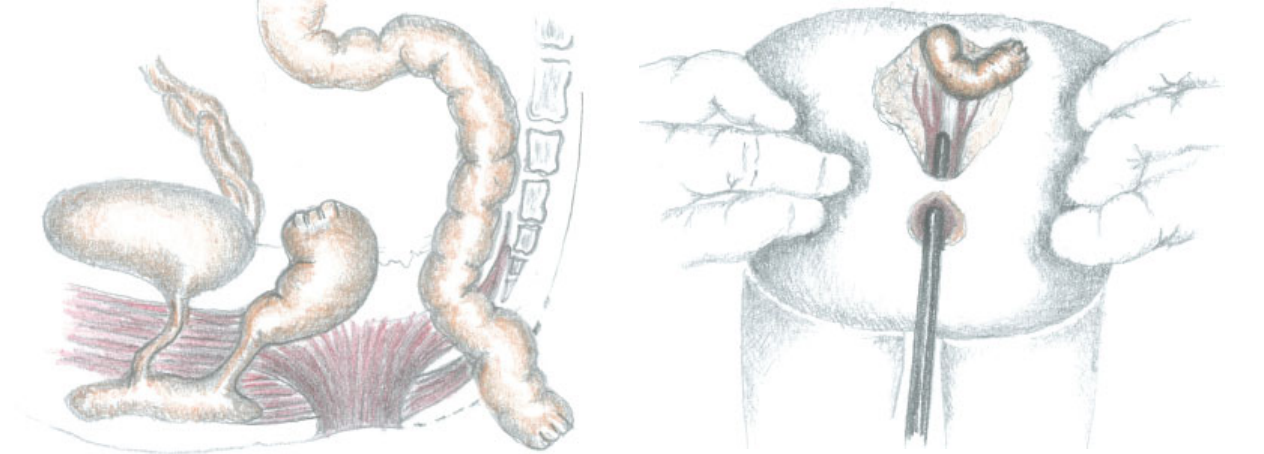
Fig. 4 Mobilized sigmoid colon passed into the posterior sagittal space.